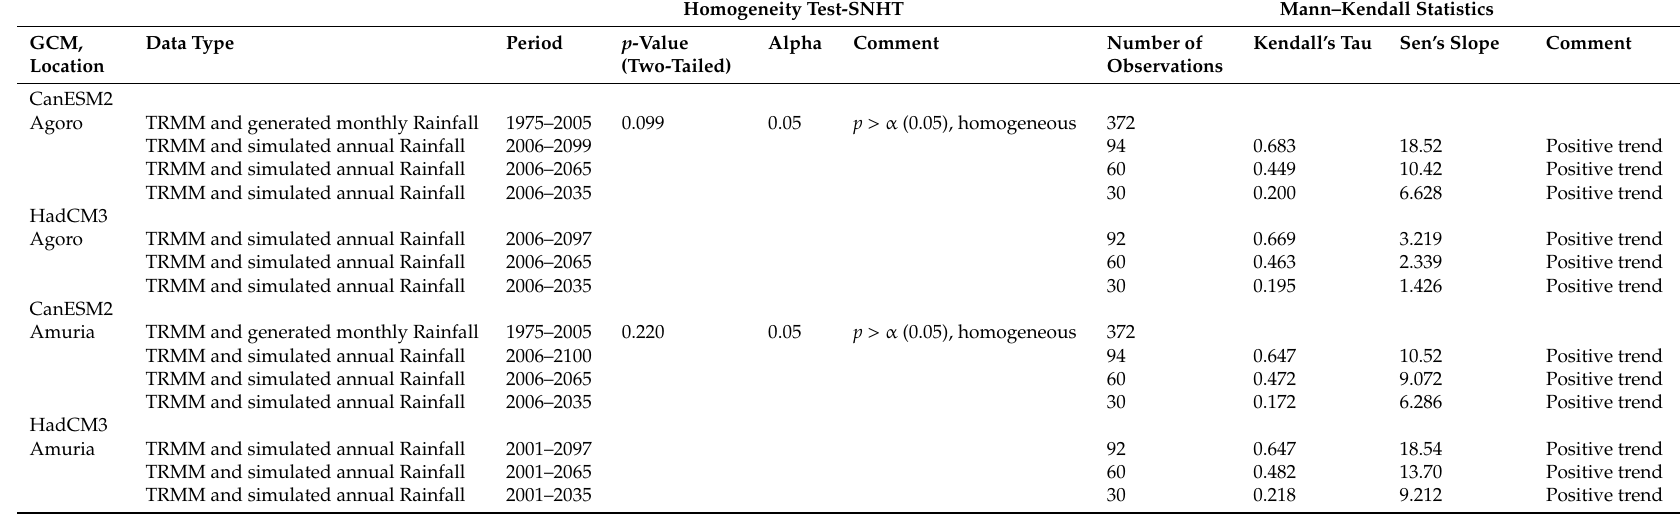
Table 5. Results of Homogeneity Test and Mann–Kendall Statistics for TRMM and Simulated Rainfall Data for Agoro and Amuria Locations in Aswa Catchment. SNHT = standard normal homogeneity